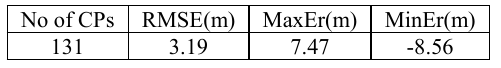
Table 1.The elevation accuracy of DSM